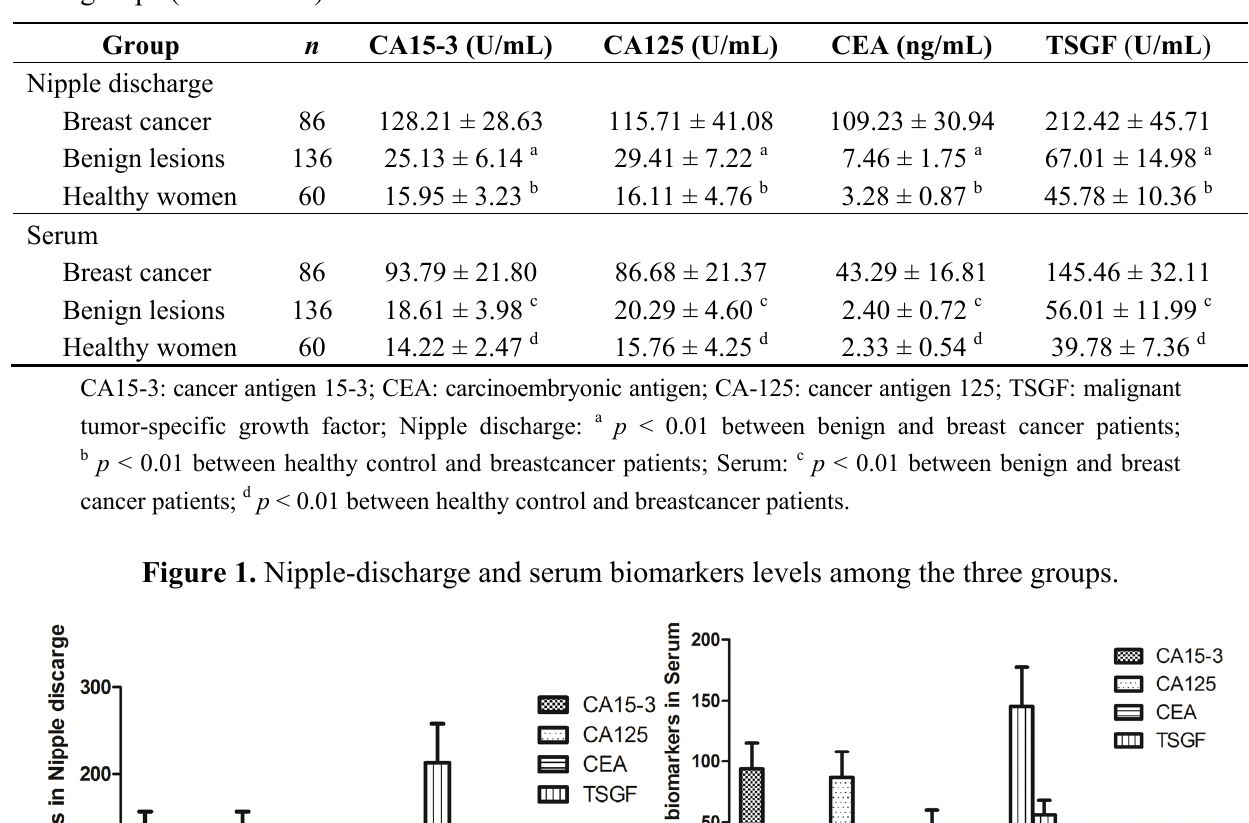
Table 1. Comparison of serum and nipple discharge biomarkers levels among the three groups (mean ± SD).